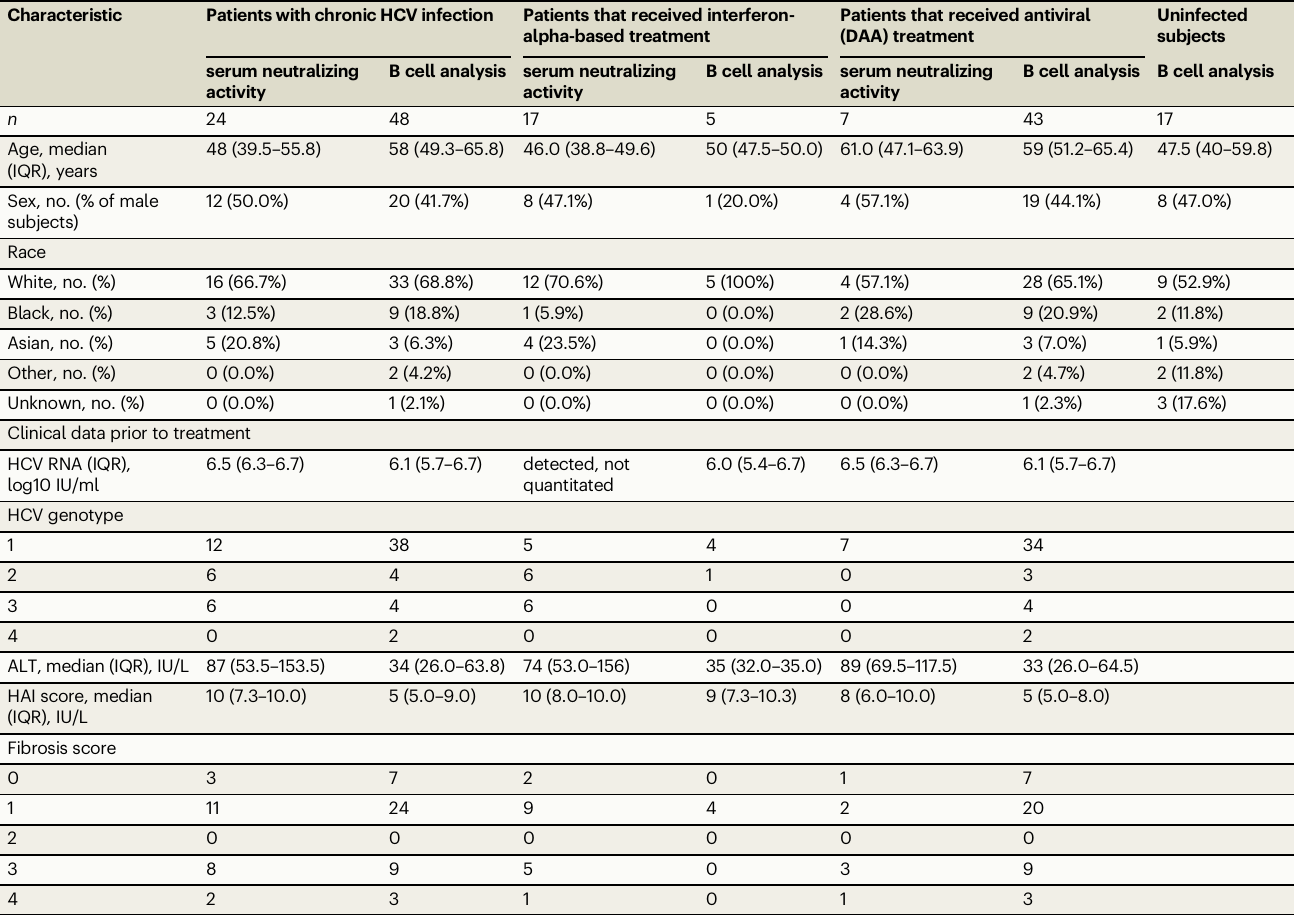
Interferon-alpha-basedtreatmentconsistedofeitherinterferon-alphaorpegylatedinterferon-alphaplusribavirinfor24,36,or48weeks.Direct-actingantiviral(DAA)treatmentconsistedofeither Sofobuvir+Velpatasvir(12 weeks) orAsunaprevir+Daclatasvir(24